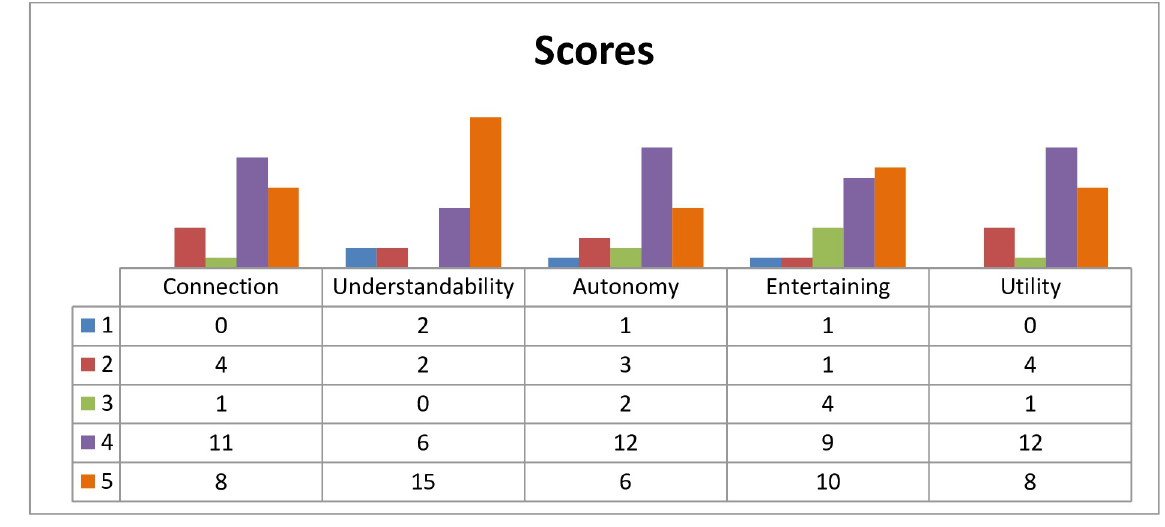
Fig 5. Users’ evaluation of voices